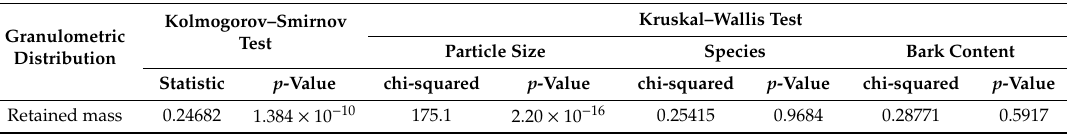
Table 2. Normality test and statistical analysis of the granulometric distribution of sawdust of four oak